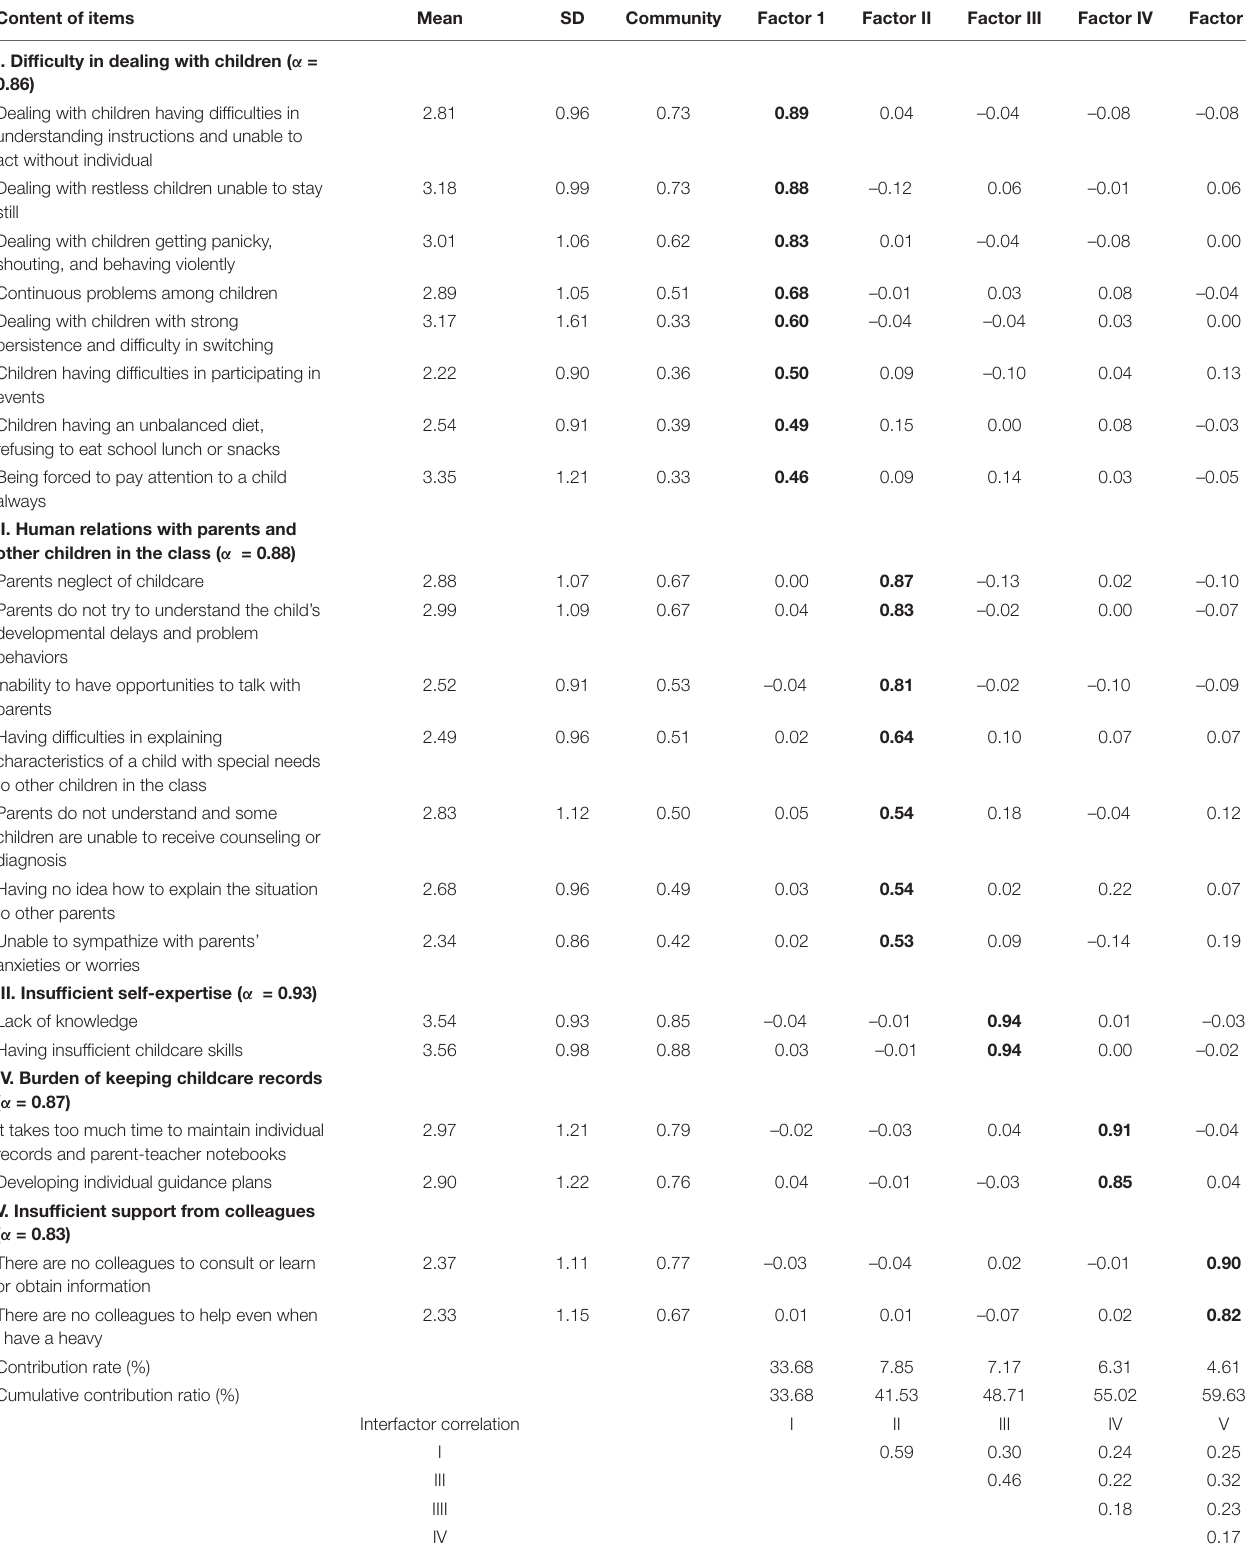
TABLE 3 | Results of a factor analysis of stressors among nursery school teachers in inclusive education. Content of